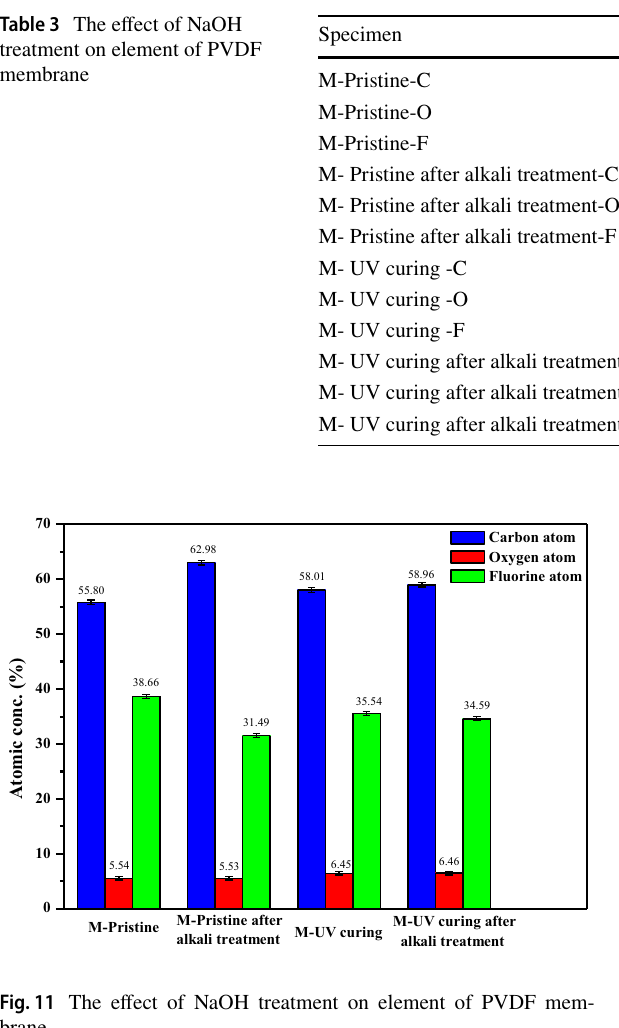
Fig. 11 The effect of NaOH treatment on element of PVDF mem-